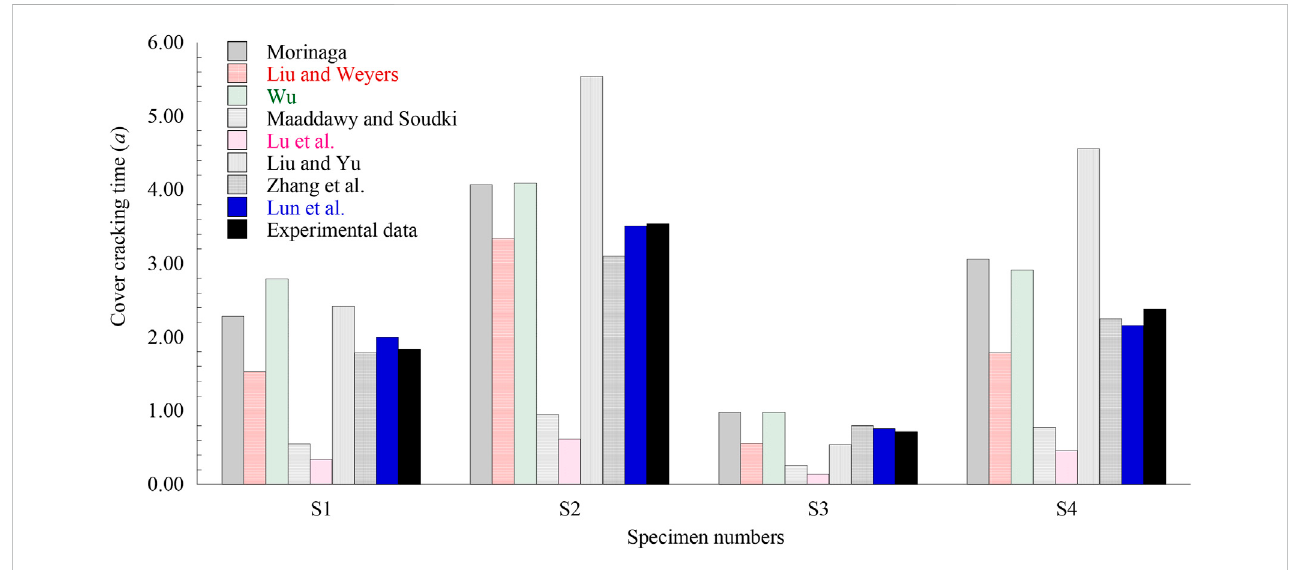
FIGURE 1 Comparison of results of different cover cracking time models.